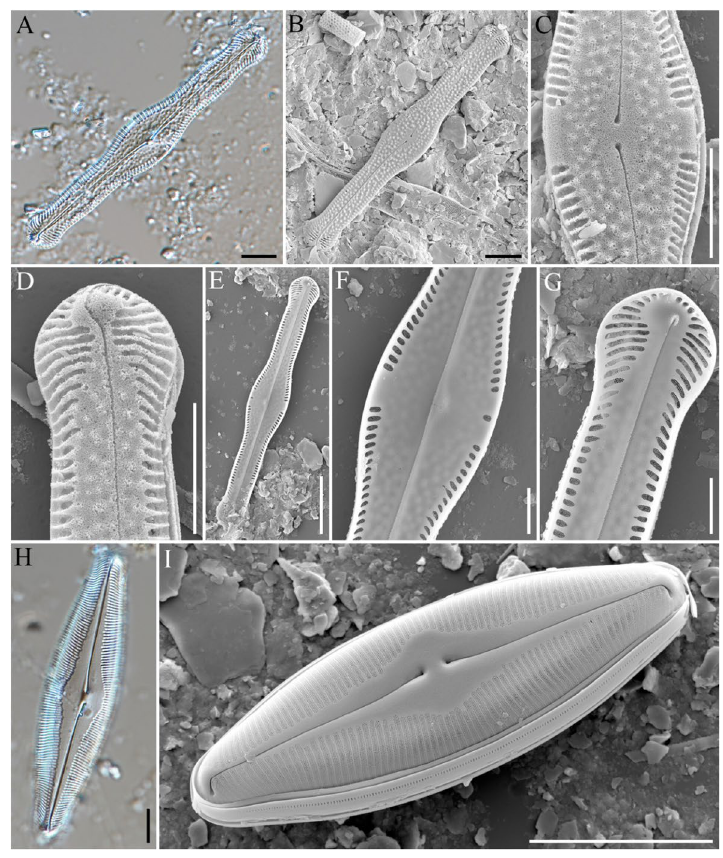
Fig. 4 Light ( A , H ) and field emission scanning electron ( B – G , I ) photomicrographs of diatoms collected from the sediment core at sampling site GG19‑01. ( A – G ) Pinnularia gibba var. hyaline . ( H , I ) P. lacunarum . Scale bars: A–D,